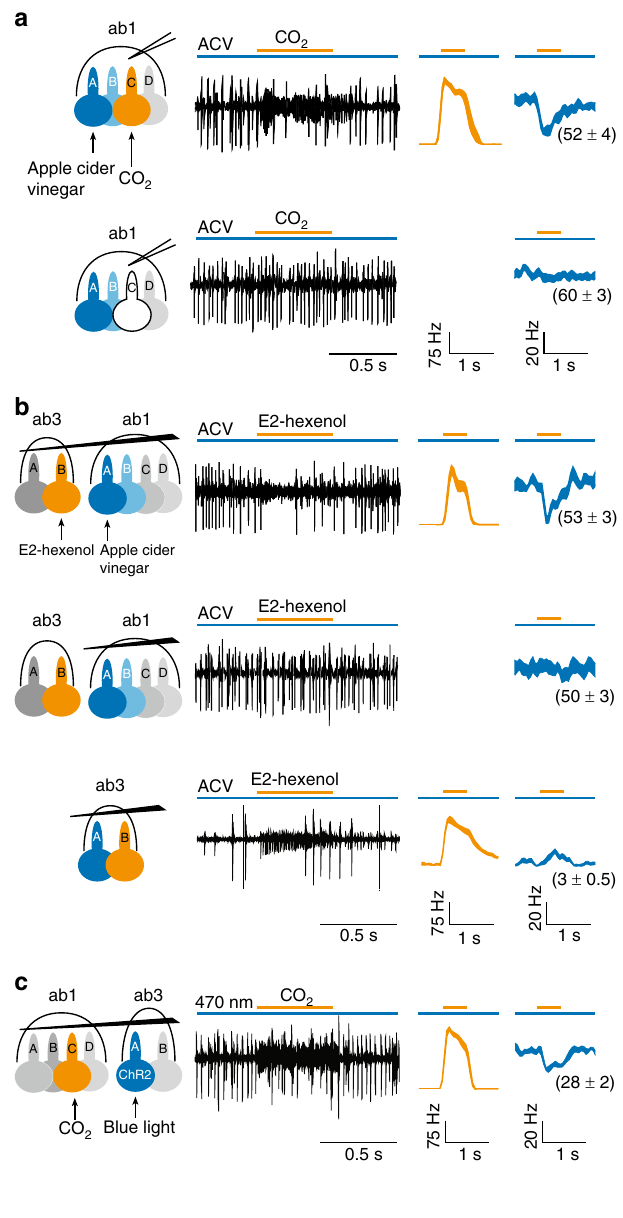
Fig. 1 Direct electrical interaction drives lateral inhibition between ORNs.